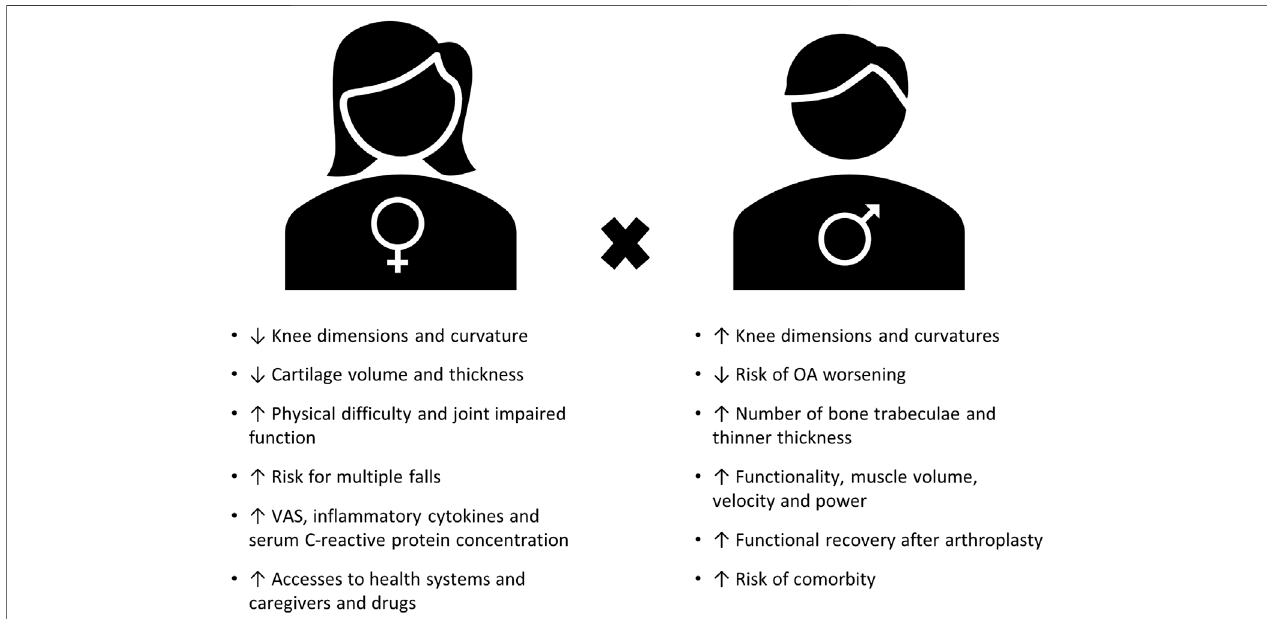
FIGURE 1 | Summary of major clinical fi ndings of sex differences in OA (adapted from (Basbaum et al., 2009; Tschon et al., 2021)).